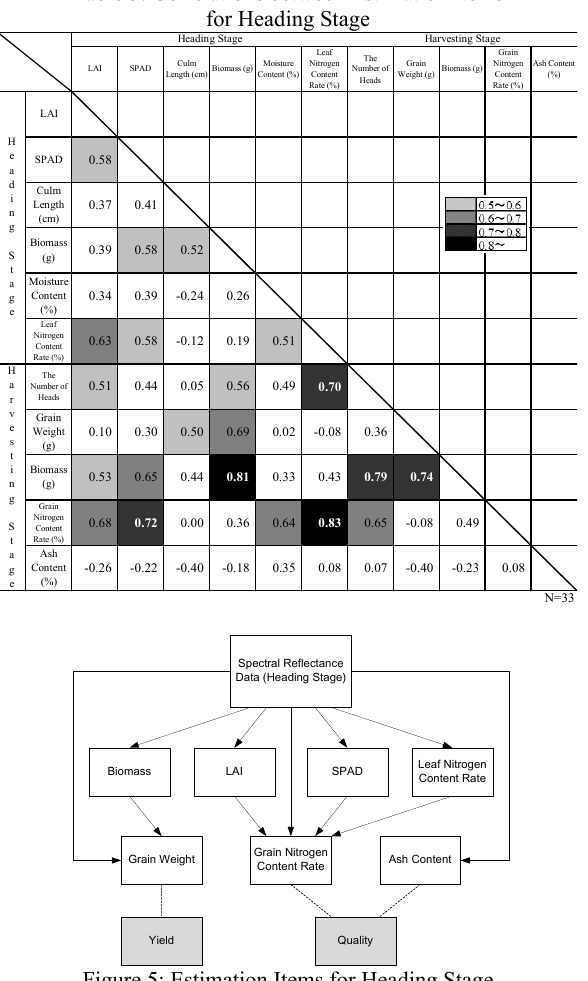
Figure 5: Estimation Items for Heading